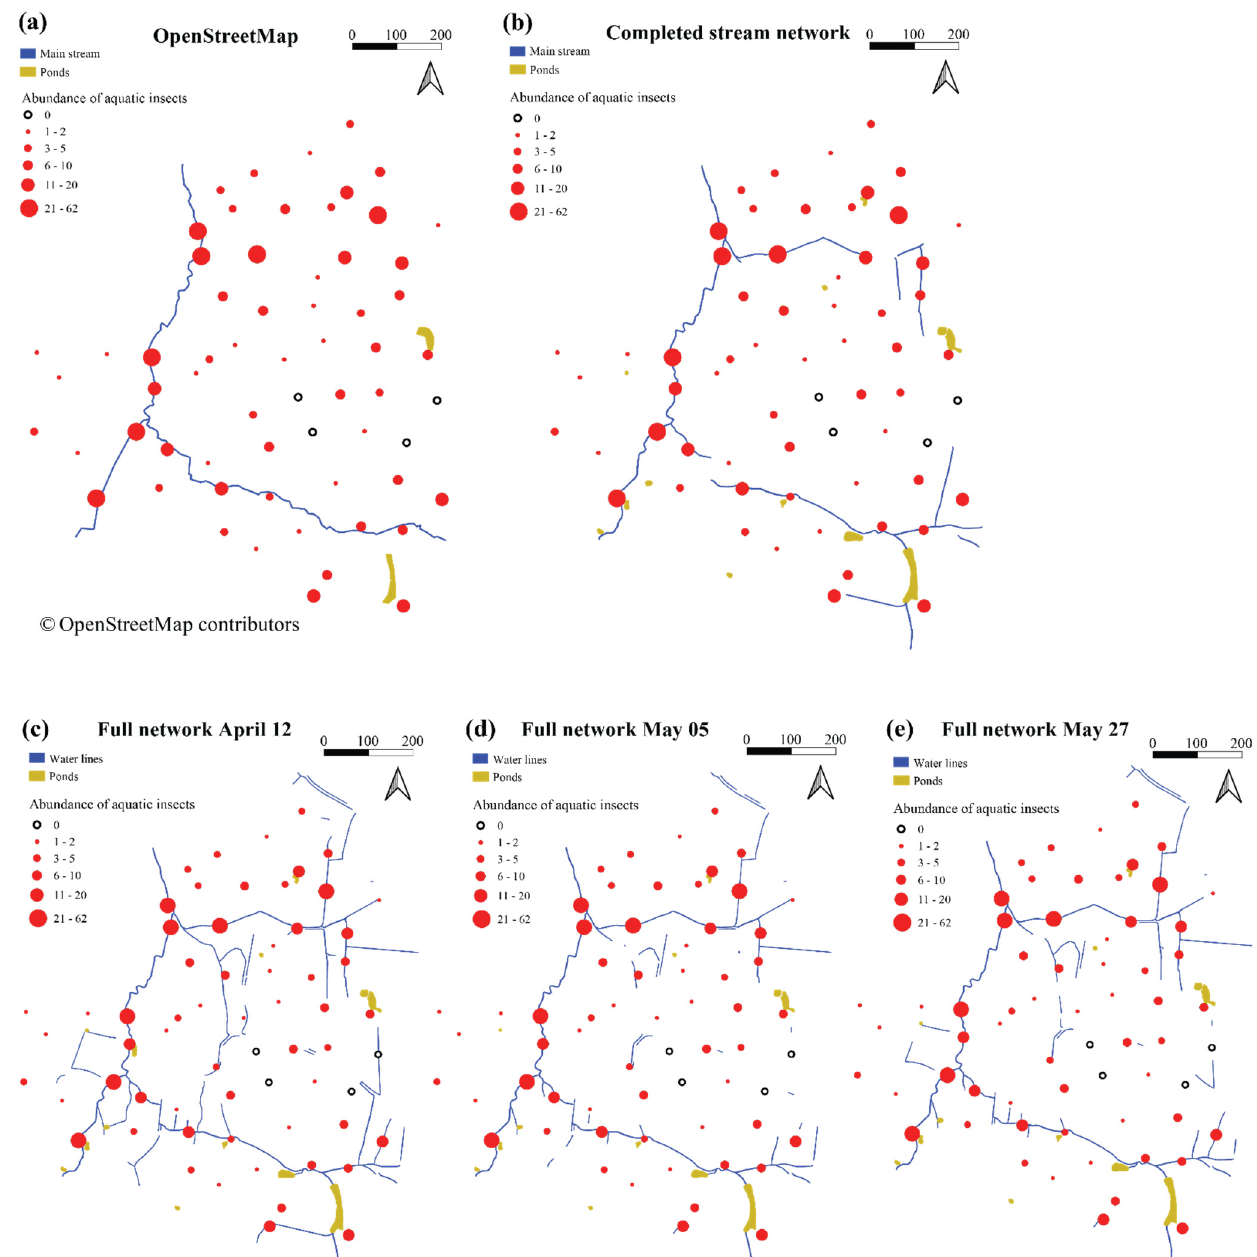
Figure 1. Hydrographic networks. ( a ) Based on OpenStreetMap, including two permanent ponds, with an abundance of aquatic insects. ( b ) The completed drainage of the stream, including the stream tributaries and the full-water ponds from 1 April to 3 June, with an abundance of aquatic insects. Hydrographic networks, including all the water bodies (stream, tributaries, ditches, and small ponds), during the survey period. ( c ) 12 April 2021, ( d ) 5 May 2021, ( e ) 27 May 2021. Then, for each session, we determined the hydrographic network that best explained the abundance of aquatic insects. Using negative binomial regressions (the “MASS” pack- age [33]) with distance to the nearest water bodies as an explanatory variable and insect